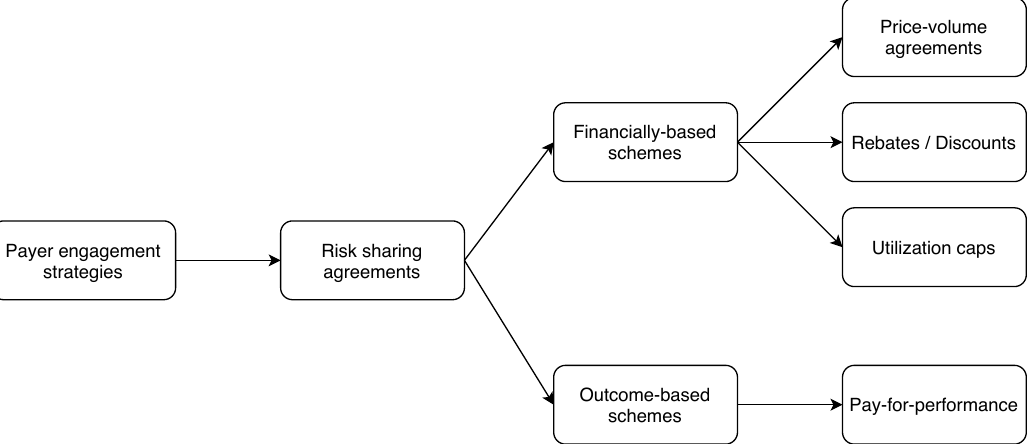
Figure 2. Examples of managed entry agreement (MEA) schemes for cost mitigation based on Akhmetov and Bubnov